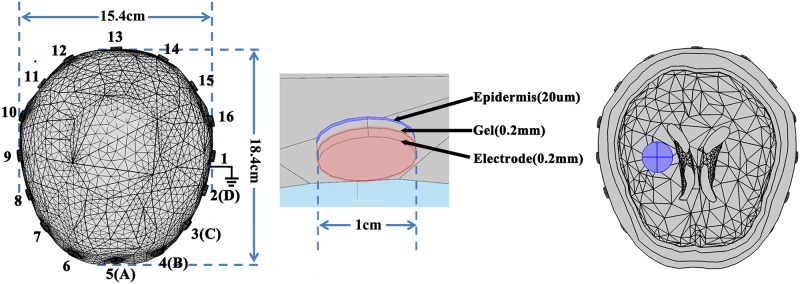
The realistic 3D head model with realistic electrode-skin interface including electrode, conductive gel and epidermis.A stroke lesion with 1.5 cm diameter was modeled.